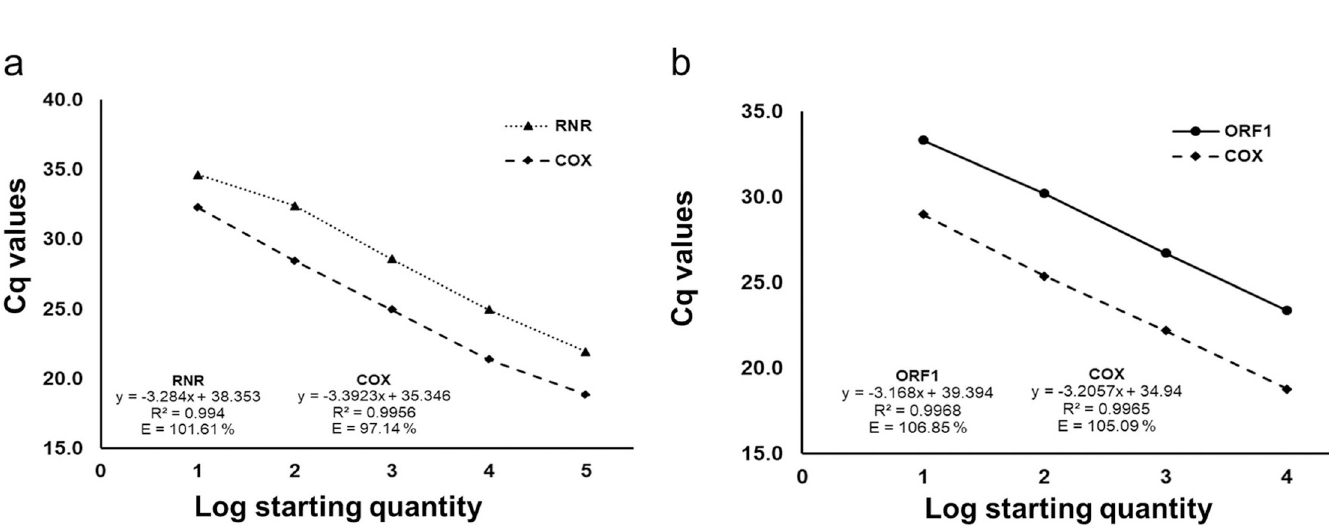
Fig 3. Calibration curve of duplex qPCR assays with tenfold serial dilution of “ Candidatus Liberibacter asiaticus” and Spiroplasma citri DNA (400 ng to 0.004 ng) performed using RNR (dotted line), ORF1 (unbroken line) and COX (dash line) gene specific primers. (a) Detection of C Las by duplex qPCR assay using RNR and COX gene; (b) Detection of S . citri by duplex qPCR assay using ORF1, and COX gene for citrus DNA.